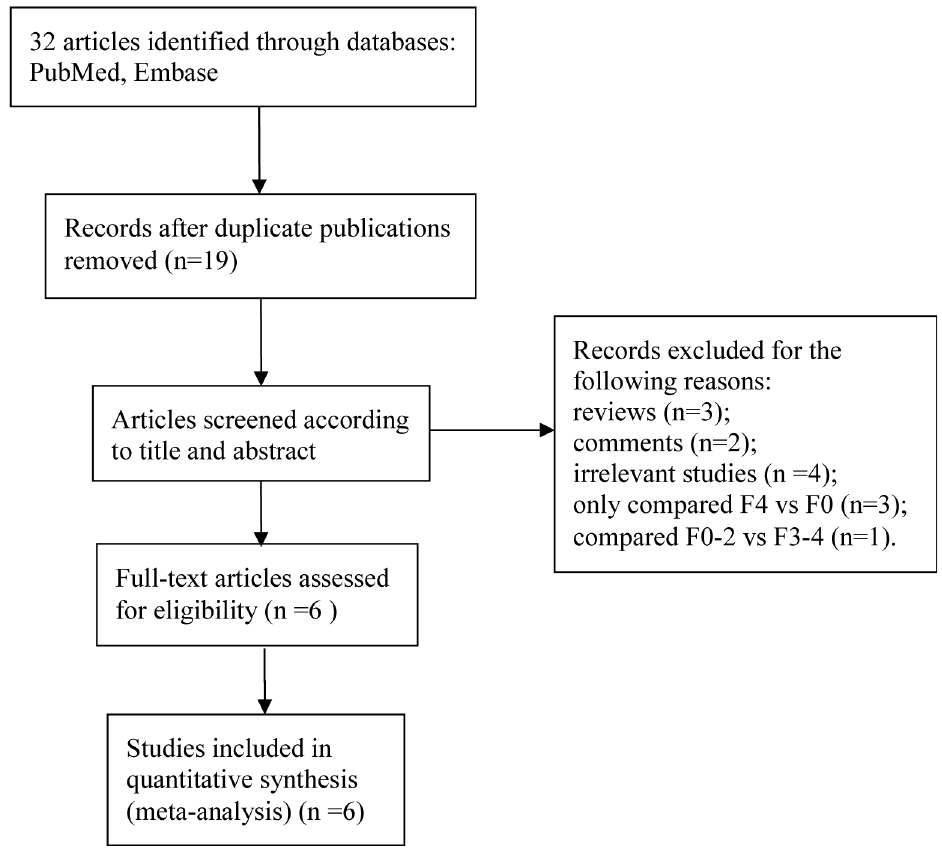
Fig 1. Flow diagram of included studies according to the inclusion and exclusion